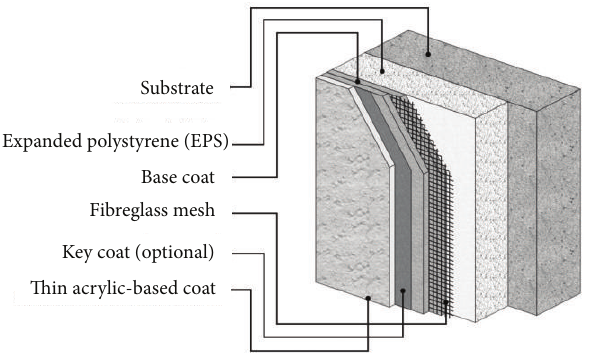
Figure 1: Schematic example of ETICS available in the Portuguese market [4].